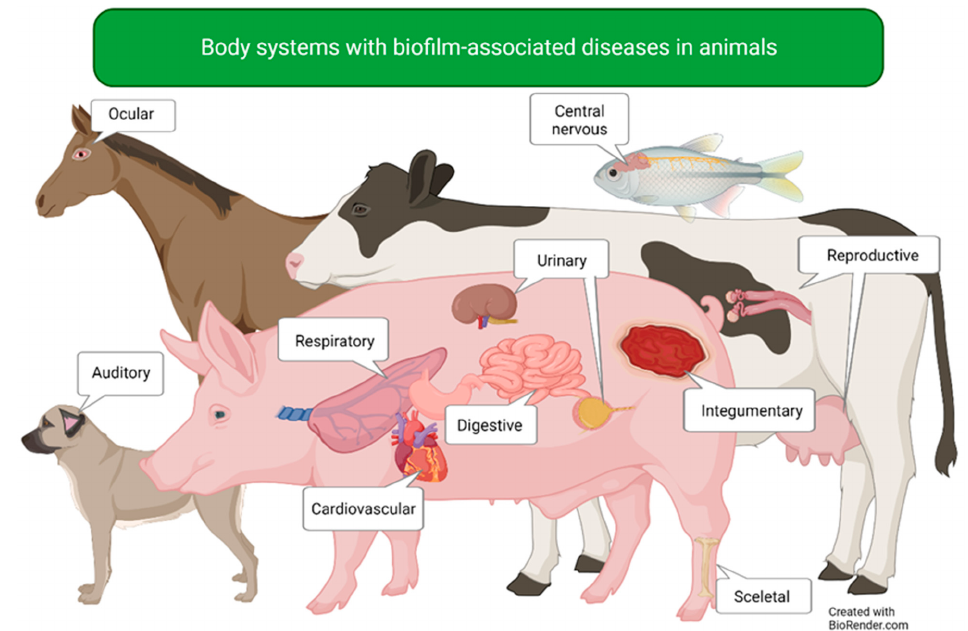
Figure 1. Body systems with biofilm-associated diseases addressed in this review.